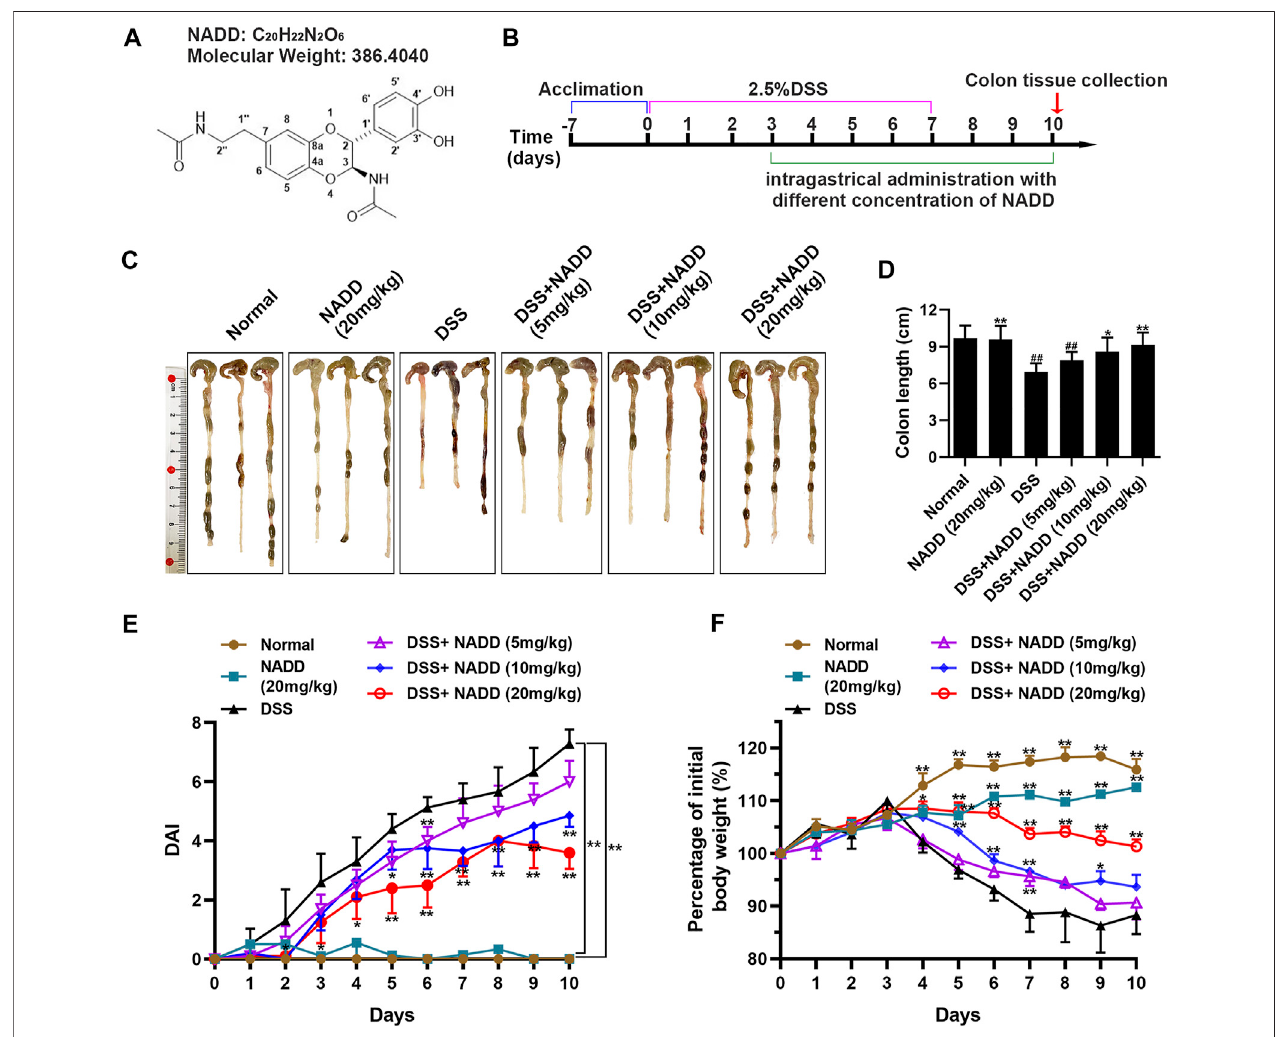
FIGURE 1 | The therapeutic effect of NADD on UC. (A) Molecular structures of NADD (B) Experiment fl ow diagram. (C) Images of murine colons among different groups of mice (D) Histogram of colon length after treatment with different concentrations of NADD. (E) DAI of mice among different treatment groups. (F) Body weight changes of mice among different treatment groups. Differences were statistically signi fi cant when compared with mice in the DSS group (* p < 0.05, ** p < 0.01).